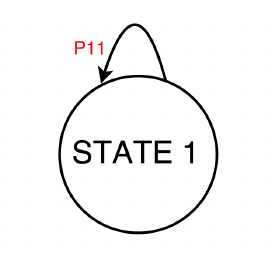
Figure 5. State machine of a washing machine taking into account user presence information for two consecutive time intervals.